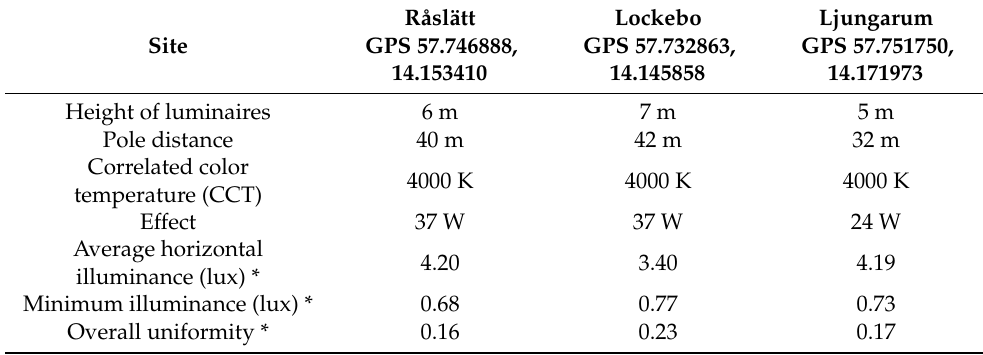
Table 2. Lighting